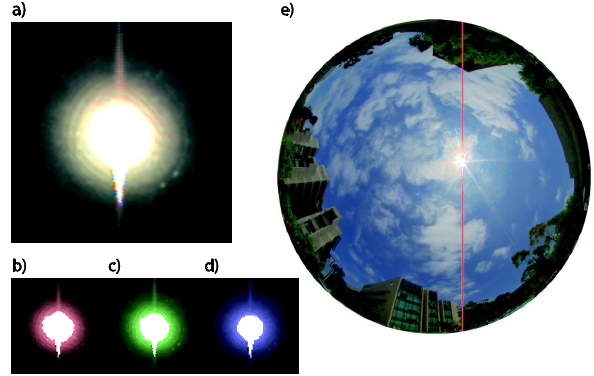
Figure 3. (a) Diffraction pattern measured with a 1000µm aper- ture on USI 1.8, with red, green, and blue color components shown Fig. 3 . (a) Diffraction pattern measured with a 1000 µm aperture on USI 1.8, with 3 in (b) , (c) , and (d) , respectively. (e) Diffraction of the hexagonal iris color red, green, and blue color components shown in (b), (c), and (d), respectively. 4 blades in the stock (e) Diffraction of the hexagonal iris blades in the stock lens. 5